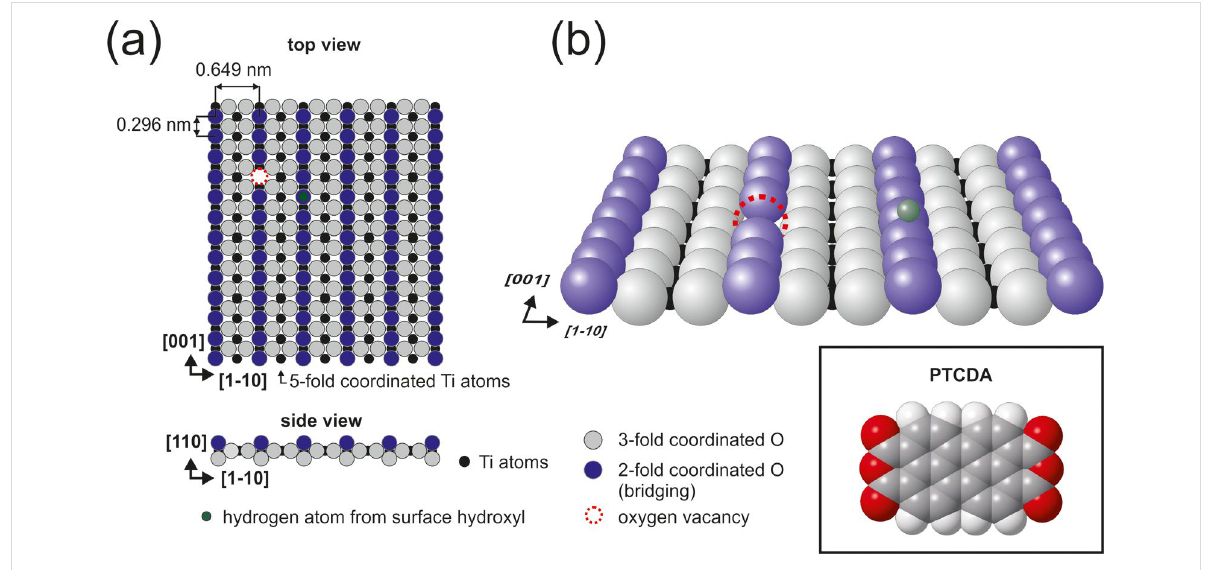
Figure 1: Structural model of the TiO 2 (110)-(1 × 1) surface: (a) top and side view, (b) perspective view. The inset in panel (b) shows the structural model of a PTCDA molecule (colour coding: grey – carbon, red – oxygen, white – hydrogen).